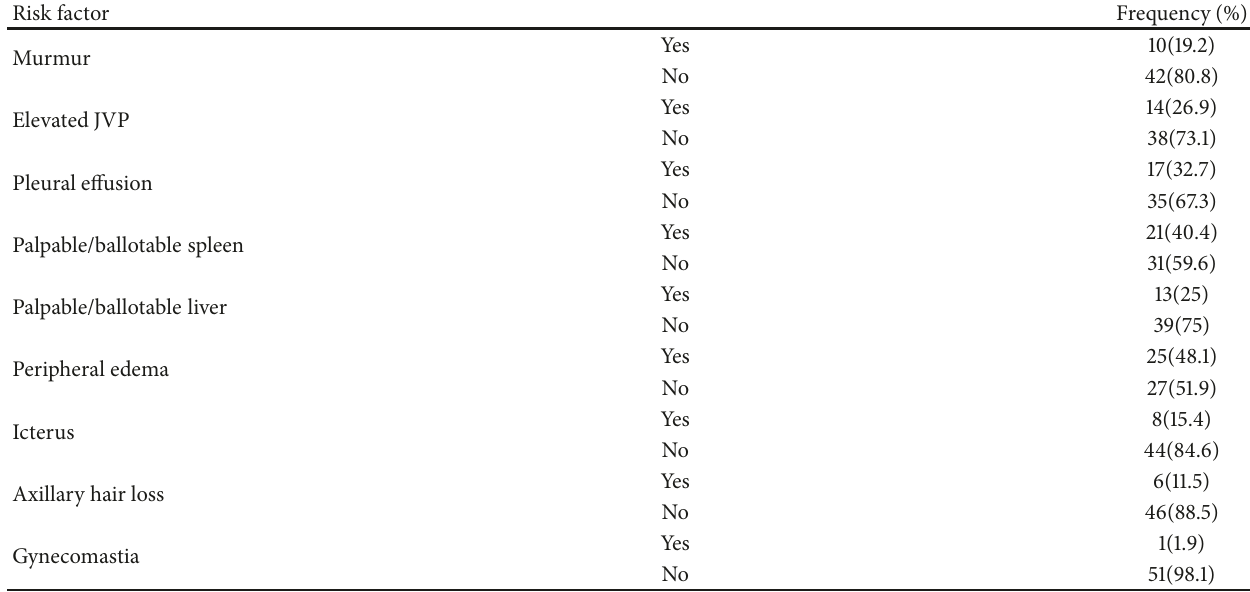
Table 3: Physical findings of the patients.